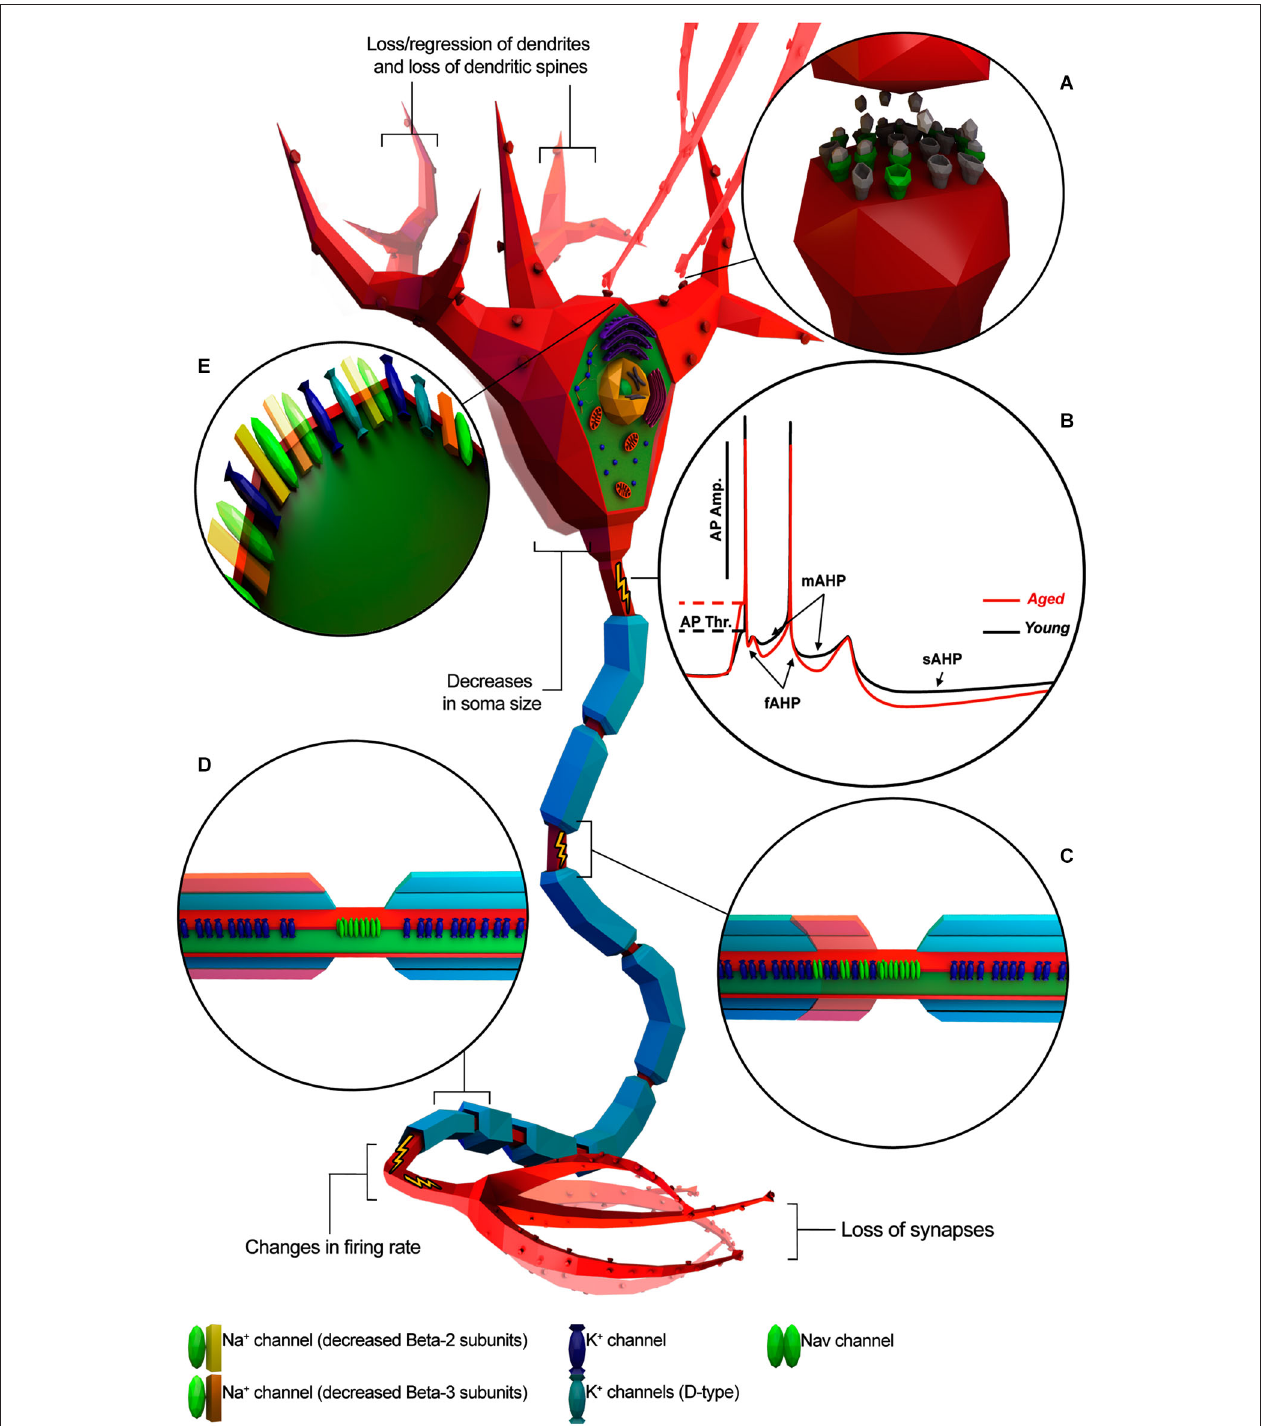
of paranodal ultrastructure (in red) leading K + channels to be relocated adjacent to “Na v ” clusters. (D) Depletion of myelin layers (in red) leading to an increase of the occurrence of redundant myelin sheaths exposing the enclosed axon. (E) Alterations in Na + and K + channel properties or subtype expression patterns. (Illustration was created using Autodesk 3Ds Max and Adobe